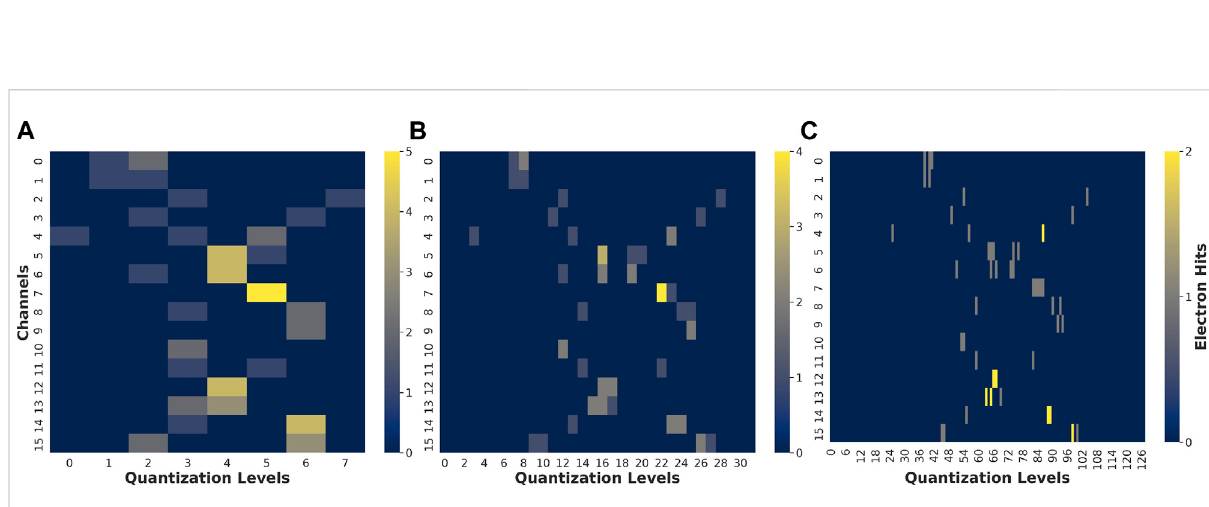
FIGURE 4 3,5and7bitsquantized dataheatmapsfora2pulsesevent[respectively (A – C) ].Forahumaneye,the5bitsquantizeddataheatmaps (B) makes the two pulses distinction less ambiguous over 3 bits quantized data heatmaps (A) . However, the 7 bits quantized data heatmaps does not improve the distinction for a human